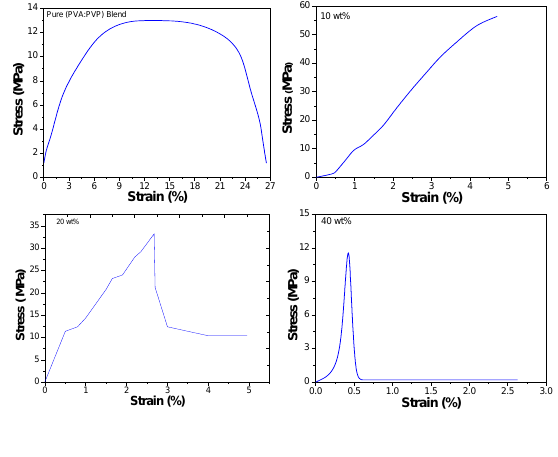
Figure 5: Stress-strain curves of pure and PVA:PVP polymer blend films reinforced with different weight ra- tios of CdCl 2 · H 2 O salt.